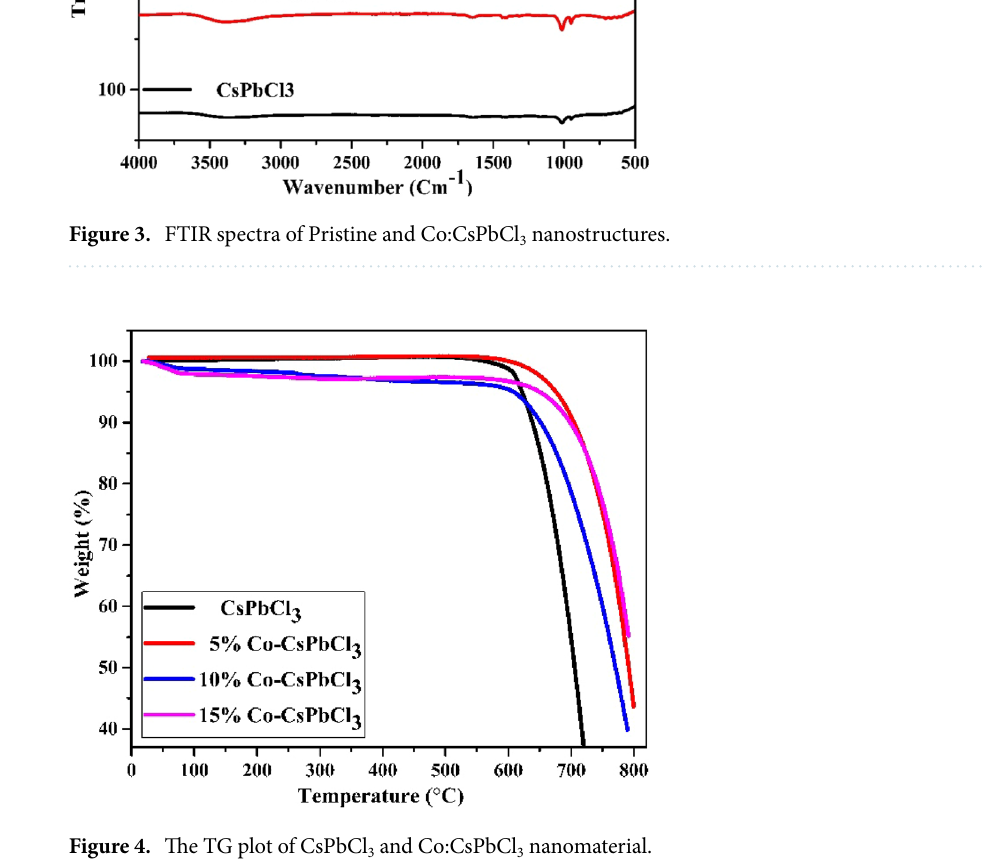
Figure 4. The TG plot of CsPbCl 3 and Co:CsPbCl 3